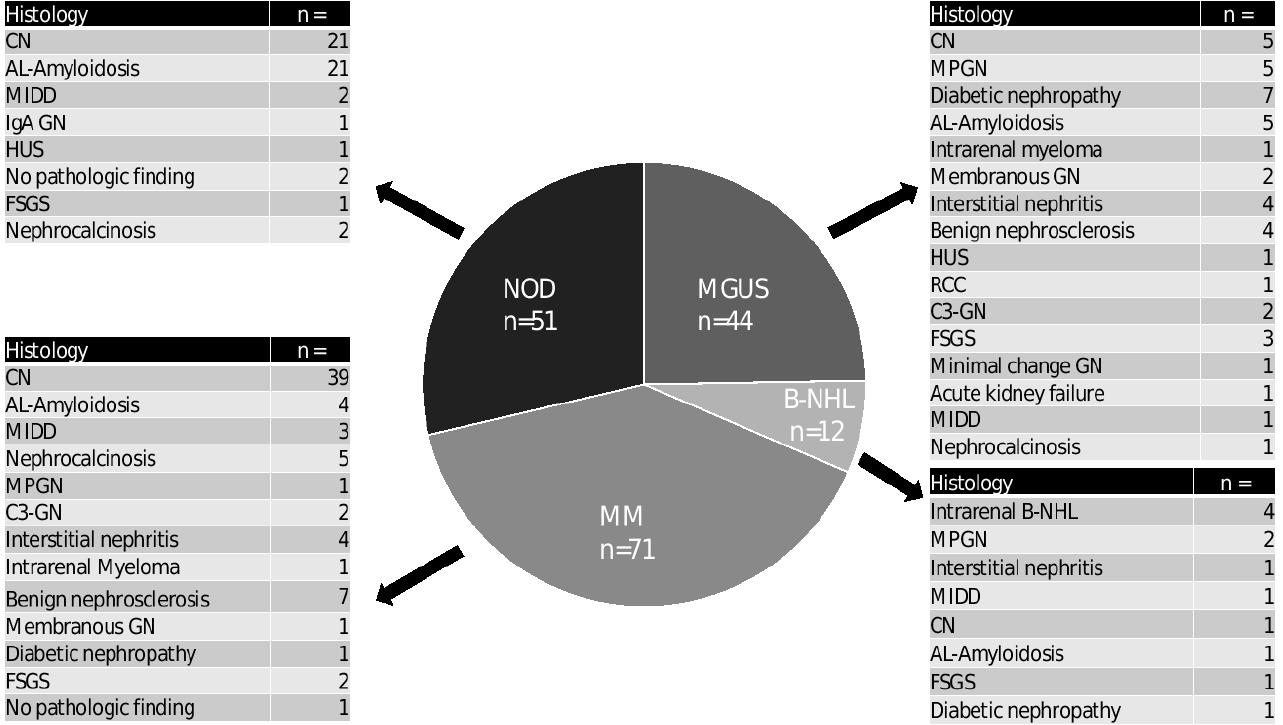
Figure 1. Histologic results of kidney biopsy separated into four clinical diagnoses prior to biopsy. Abbreviations: ALA, AL amyloidosis; CN, cast nephropathy; diabetic NP, diabetic nephropathy; FSGS, focal segmental glomerulosclerosis; HUS, hemolytic uremic syndrome; IgA GN, IgA glomerulonephritis; MIDD, monoclonal immunoglobulin deposition disease; MGN, membranous glomerulonephritis; and MPGN, membranoproliferative glomerulonephritis. The separation of the histologies in the ORD group into myeloma-associated findings and non-associated findings showed 13 myeloma-associated cases. These were five cases of nephrocalcinosis due to malignancy-related hypercalcemia, one case of MPGN, two cases of C3 glomerulonephritis (C3GN), four cases of interstitial nephritis and one case of intrarenal myeloma. The 11 cases of non-associated findings were benign nephrosclerosis ( n = 7), membranous glomerulonephritis (MGN) ( n = 1), diabetic nephropathy ( n = 1) and FSGS ( n =